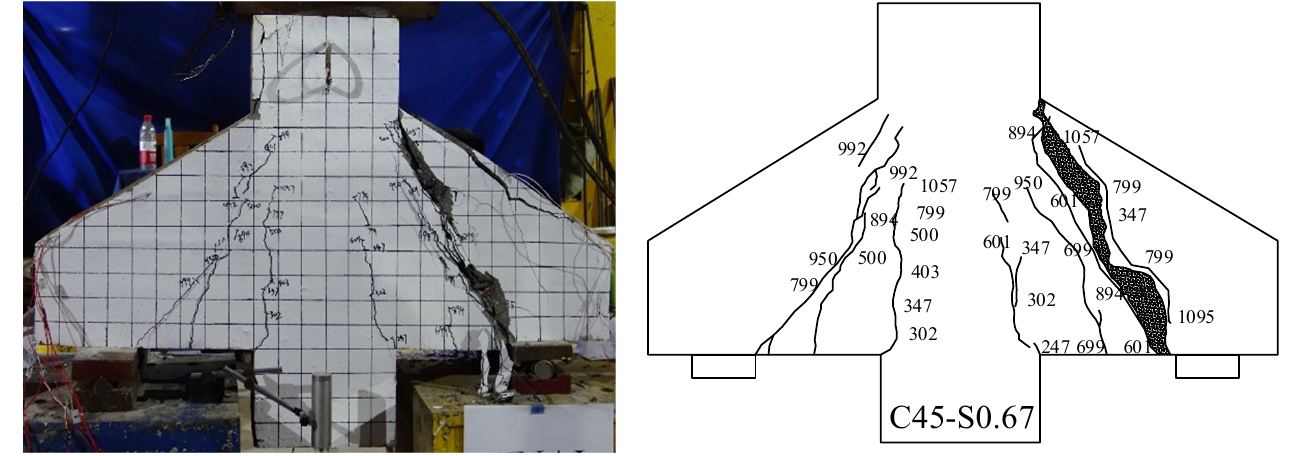
Figure 4. Typical failure mode and crack distribution (specimen C45-S0.67).